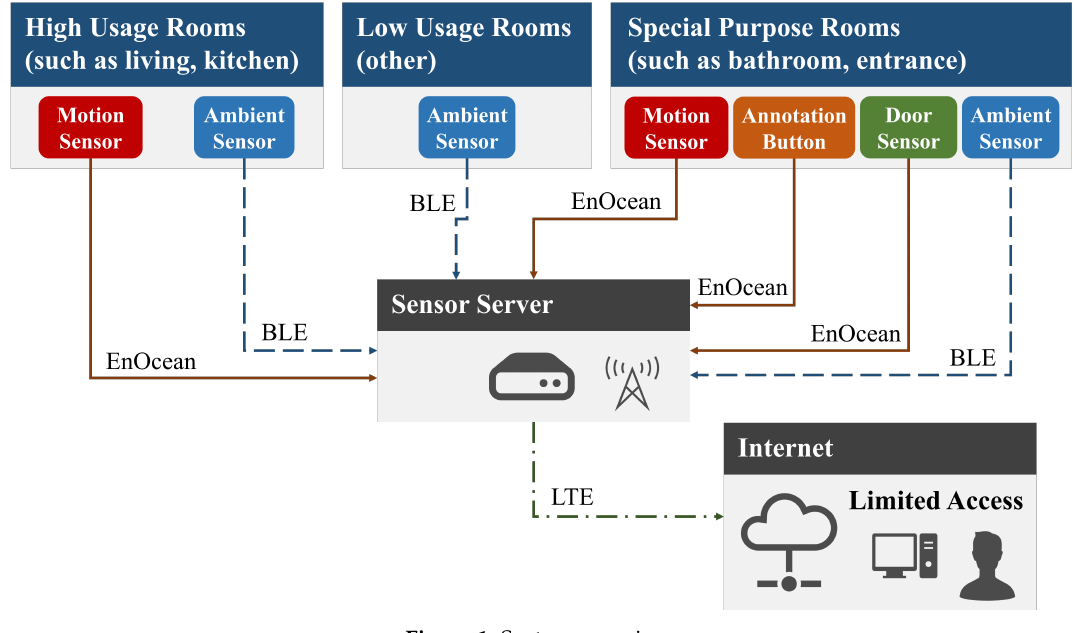
Figure 1. System